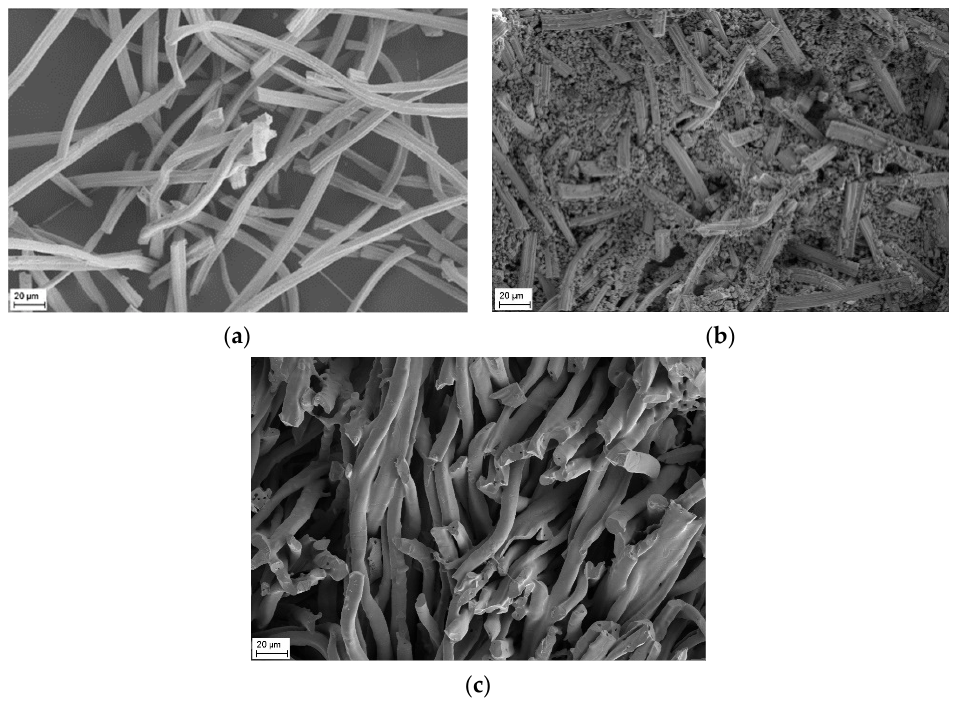
Figure 3. SEM micrographs of pure YSZ fiber after thermal treatment at 1923 K for 2 h ( a ) and SEM micrographs of YSZ fiber mixed with CeO 2 after thermal treatment at 1573 K ( b ) and 1923 K ( c ).